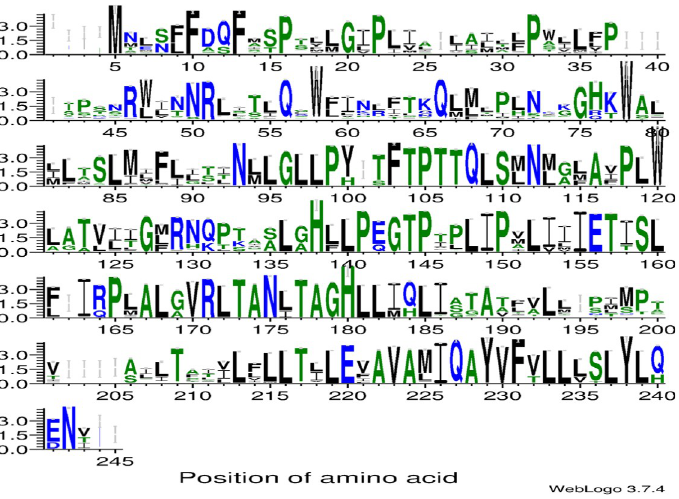
Fig 5. Sequence logos displaying conservation of residues created for all aligned blocks of the MSA for protein ATP synthase F 0 subunit 6 for 5947 vertebrate species from NCBI using webserver WebLogo (http://weblogo. threeplusone.com/) the y axis represents probability of the residue occurring at that position from the MSA.